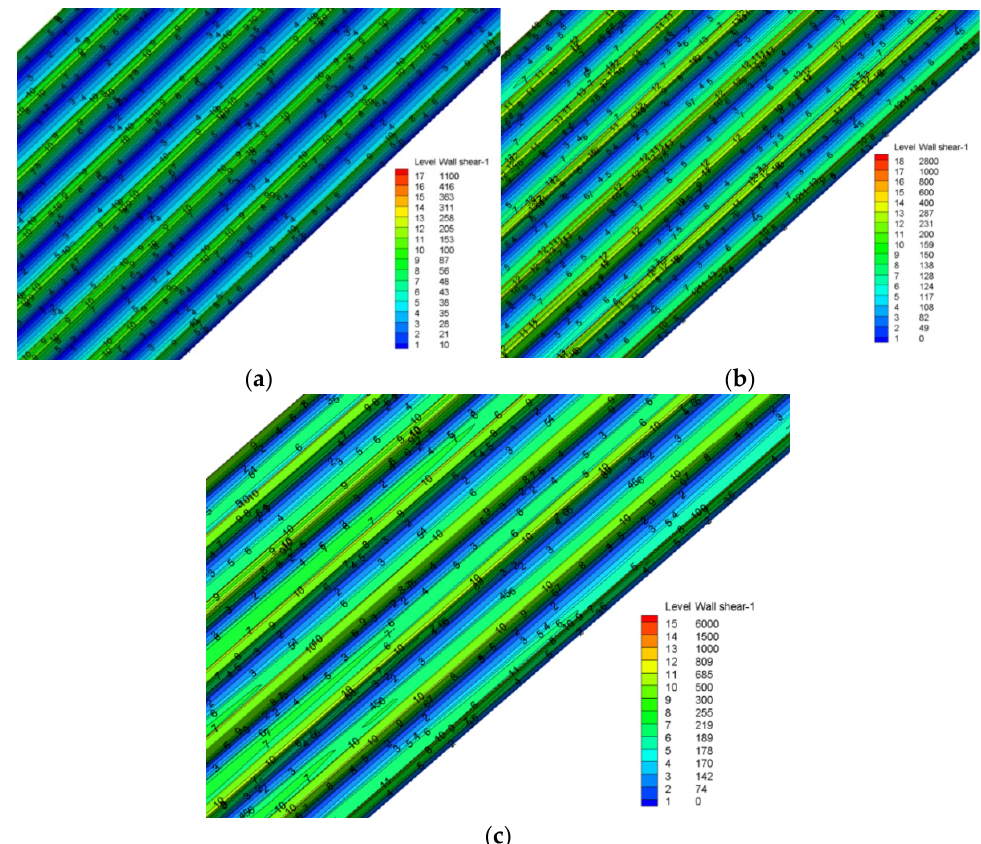
Figure 26. Wall shear stress analysis of rectangular groove plate under different Mach numbers; ( a ) 0.3 Ma; ( b ) 0.5 Ma; and ( c ) 0.8 Ma. For further analysis of the wall shear stress of the rectangular groove, five straight lines along the flow direction were taken on the wall. The specific positions of the straight lines were, respectively, in the top step of groove y = 0 m, z = 0.0004271 m, the top, middle and bottom parts of groove plumb wall z = 0.00044 m corresponding to y = − 0.00001 m, y = − 0.00005 m, y = − 0.00009 m and y = − 0.0001 m, z = 0.0005 m at the bottom of the groove. The data extracted on a straight line with the drawn shear stress distribution curve are shown in Figure 27.